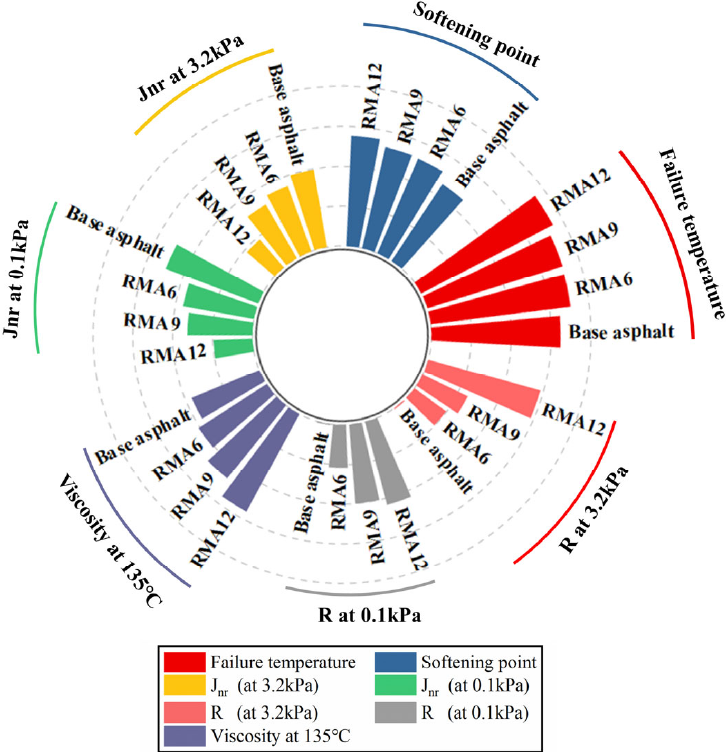
Figure 20. High-temperature performance index of asphalt binders. Figure 20. High ‐ temperature performance index of asphalt binders. Figure 20. High ‐ temperature performance index of asphalt binders.